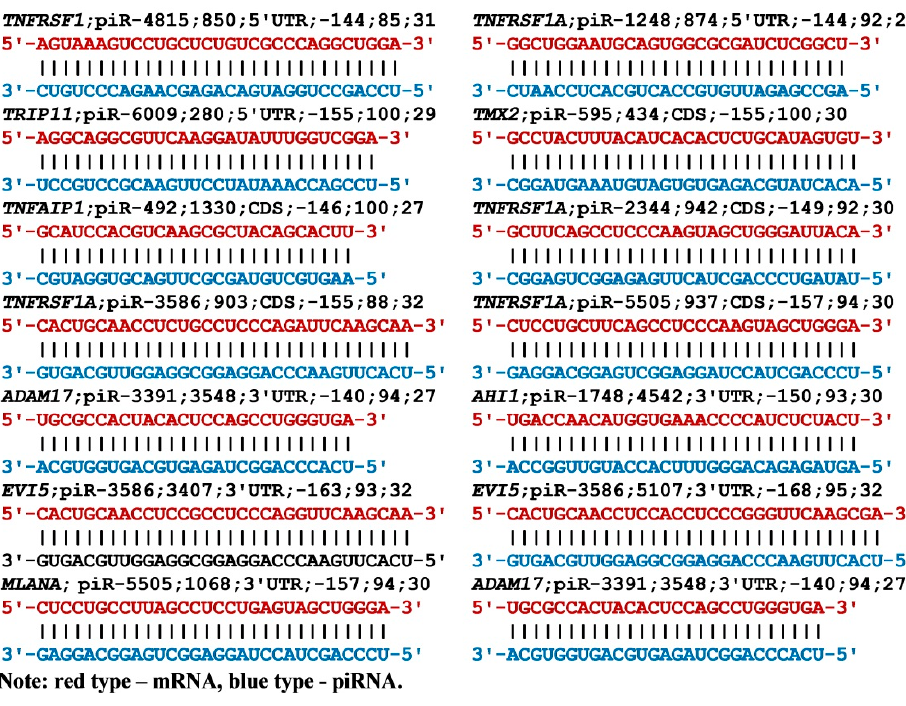
Figure 2. Schemes of interaction between piRNA and 5’UTR, CDS, and 3’UTR mRNA of MS candidate genes.